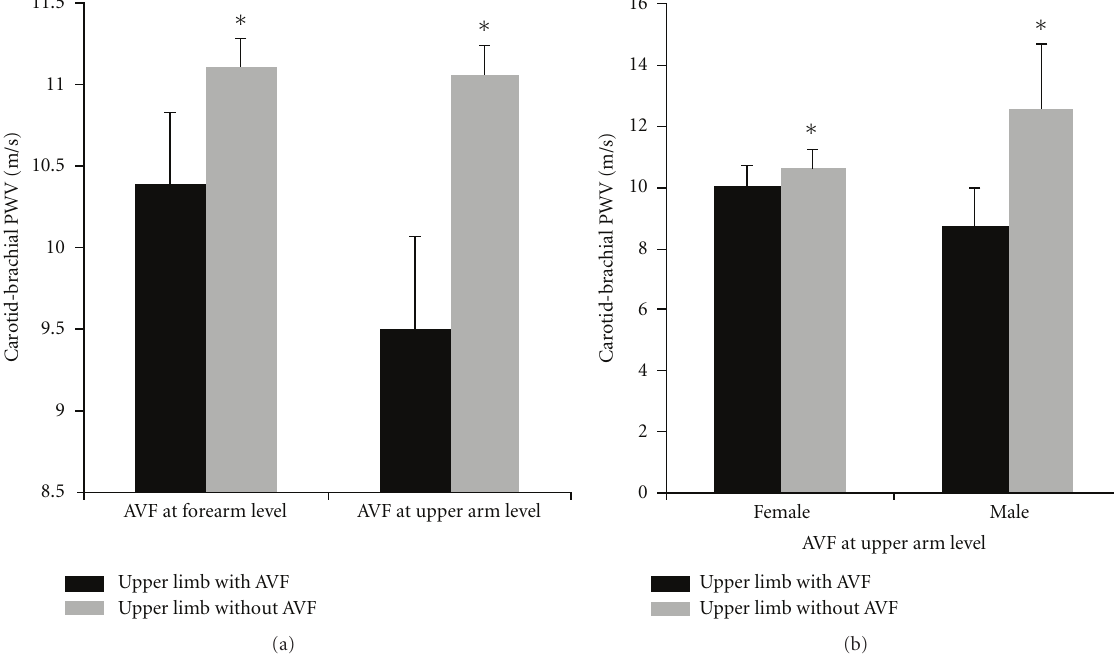
Figure 1: Comparison between carotid brachial pulse wave velocity (PWV) values (mean ± SD) obtained in upper limbs with arteriovenous fistulae (AVF) with respect to their contralateral intact limbs ( ∗ P < 0 . 05). The analysis discriminates between vascular accesses performed at upper arm and forearm level (a), and between genders when the vascular access was performed at upper arm level